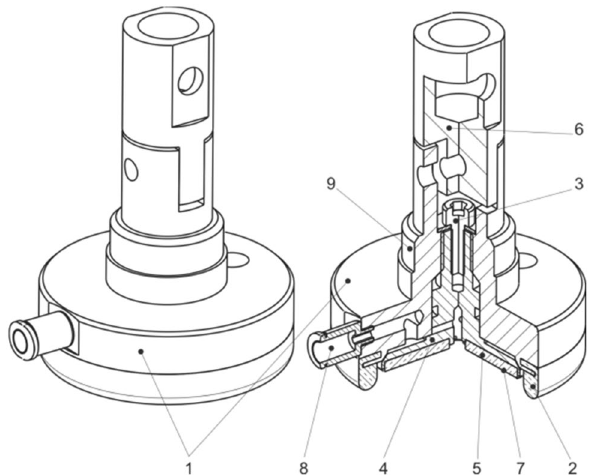
Fig. 24 Vacuum adhesive gripping element